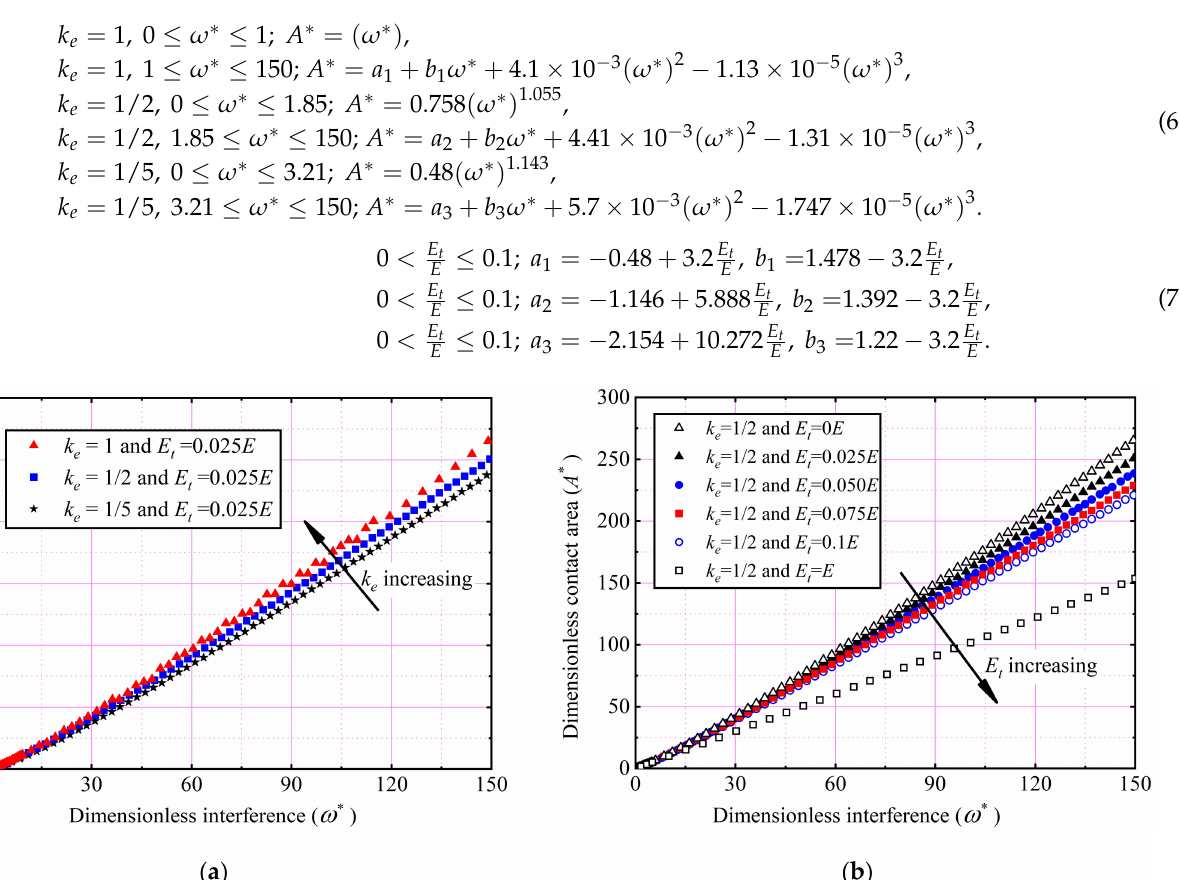
Figure 5. Evolution of A * with increasing ω * : ( a ) under different values of k e ; ( b ) under different E t values.